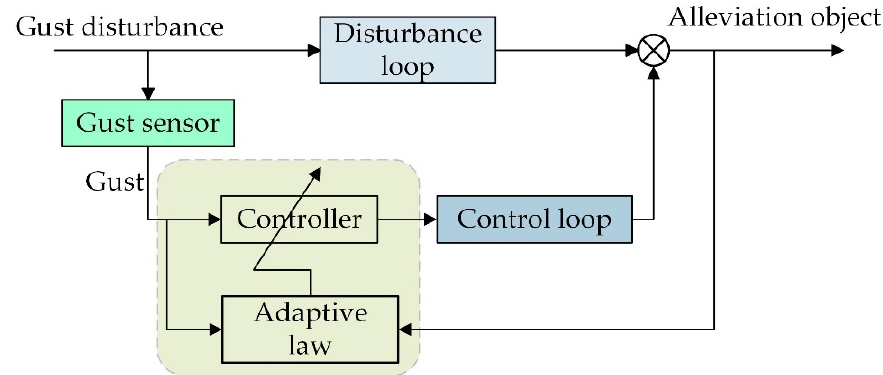
Figure 3. Feedforward control principle of gust alleviation.